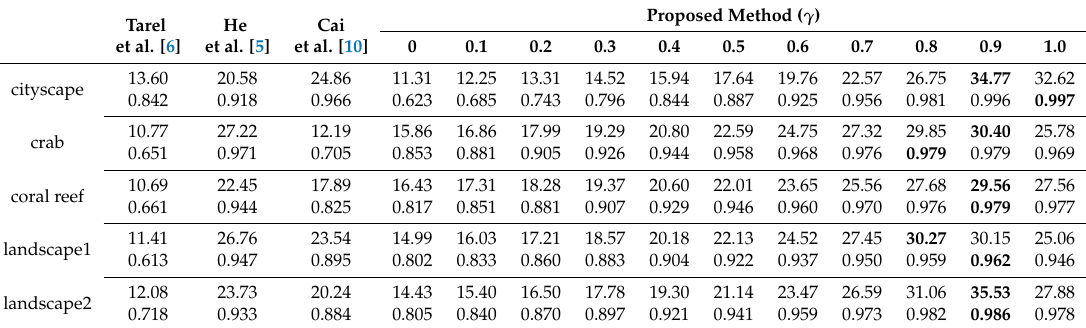
Table 1. Quantitative evaluation with PSNR and SSIM [24] for simulated haze images generated using uniform transmission map ( t = 0.5). First row is PSNR value, and second row is SSIM value in each cell. Proposed Method ( γ Tarel He Cai